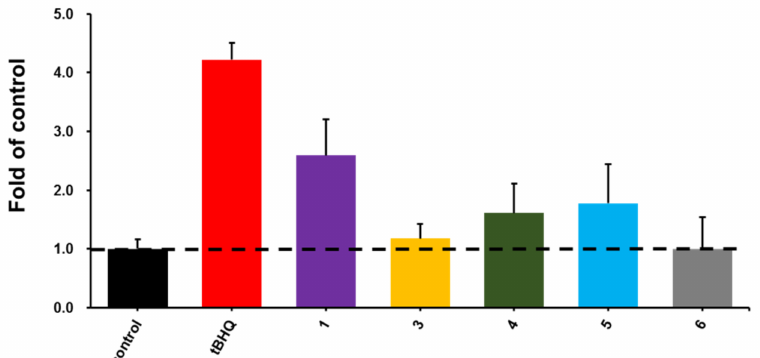
Figure 3. The activation activities on Nrf2 transcription of compounds 1 and 3 – 6 at 10 µ M, with tertiary butylhydroquinone (tBHQ) as the positive control. The activation potency of compounds were shown by the folds of the transcription activation level when cells were treated with